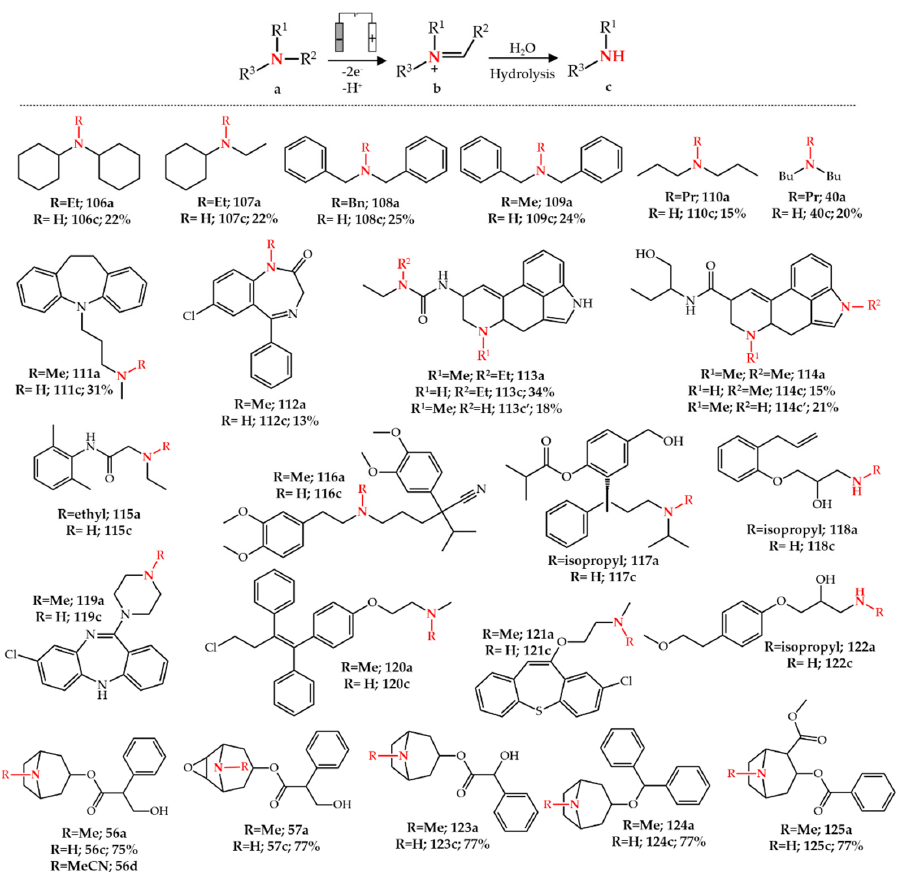
Figure 16. Electrochemical N -dealkylation of various pharmaceuticals.